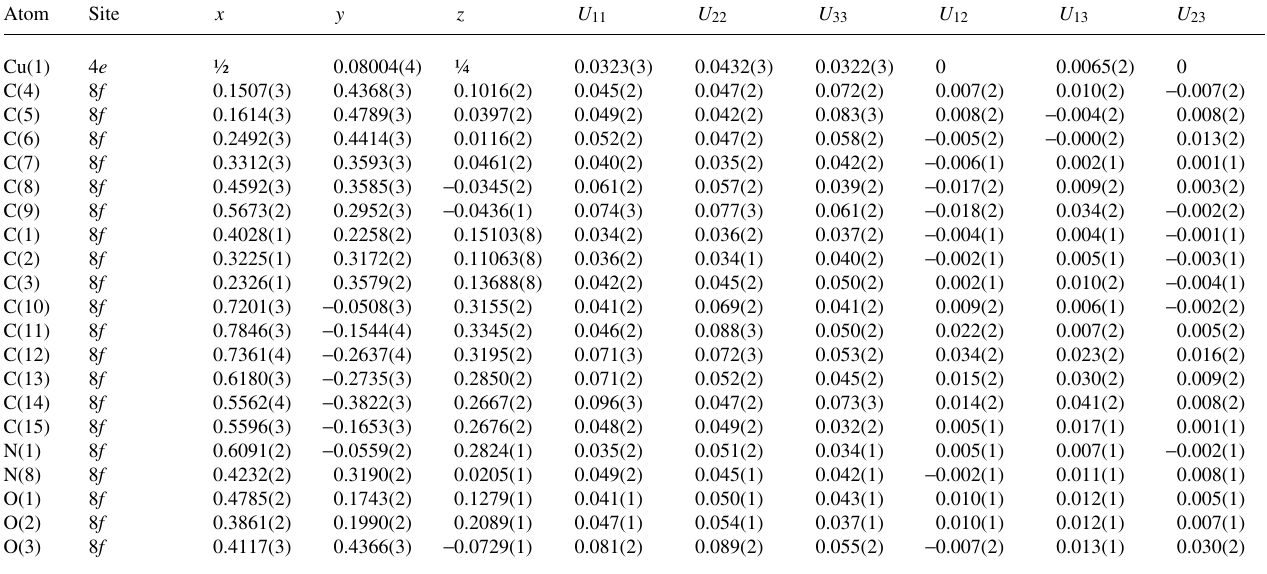
Table 3. Atomic coordinates and displacement parameters (in Å 2 ) .